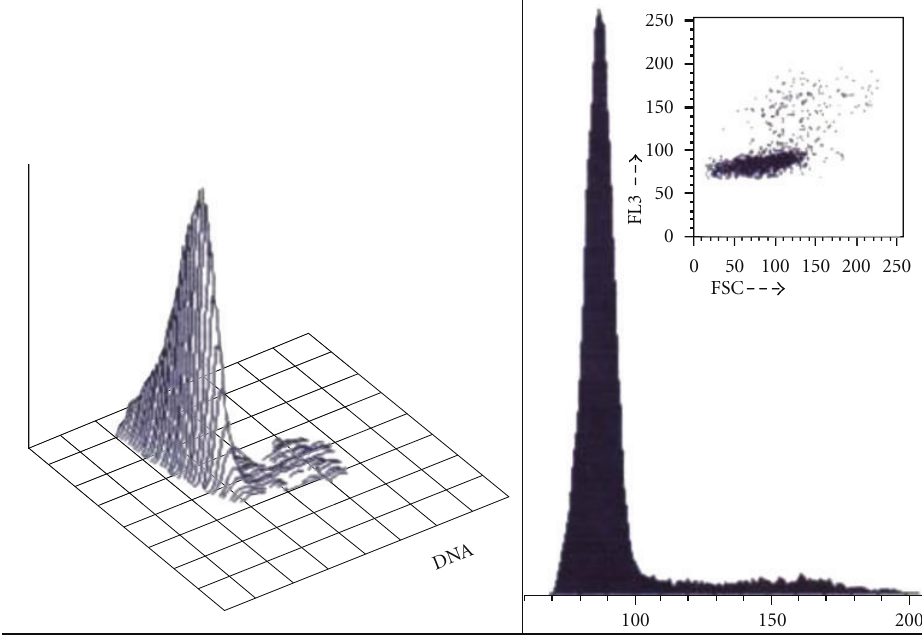
Figure 1: Example of DNA flow cytometry in a MM metastasis showing a variable content in cell